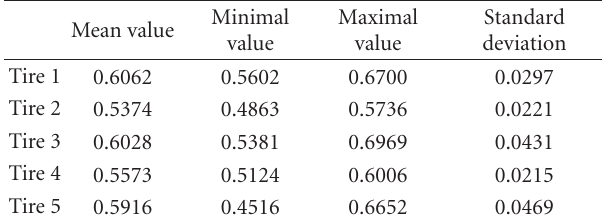
Figure 5: Examples of processed contact patches. Table 2: Coe ffi cients of tread pattern